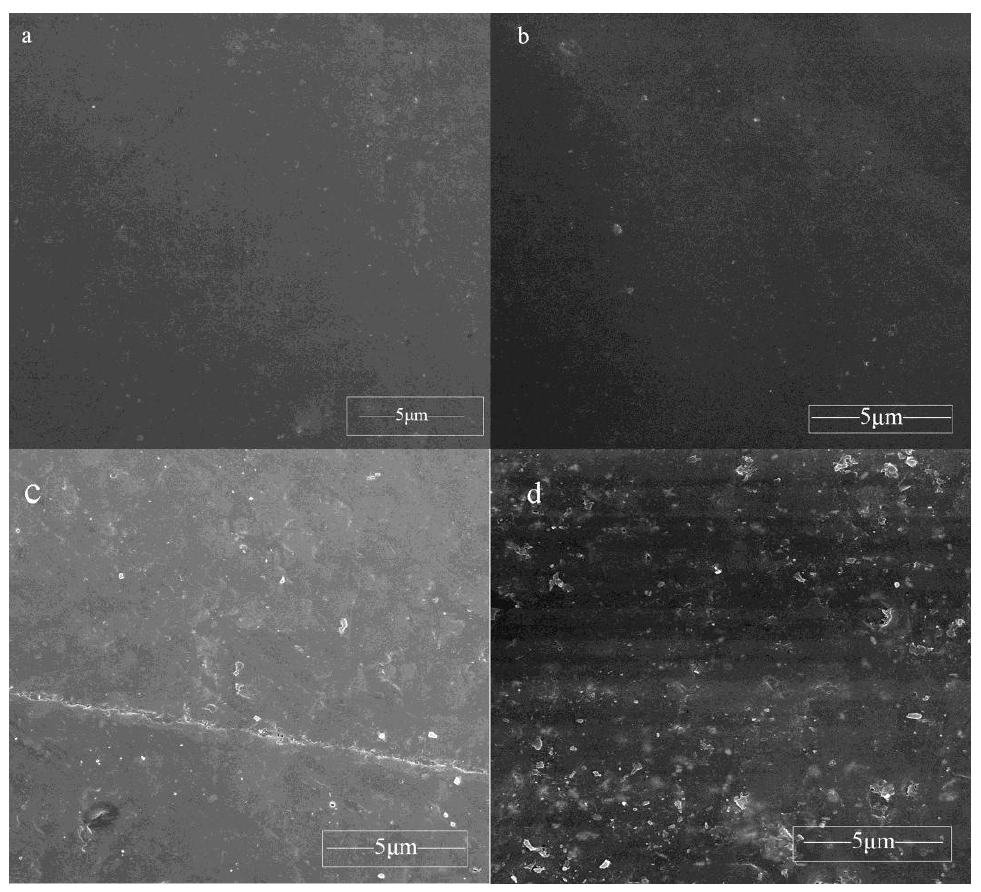
Figure 8. SEM of CDI–OA–APS–ZnO/UP composite containing 1 wt % ( a ), 3 wt % ( b ), 5 wt % ( c ), and 10 wt % ( d ) nanoparticles.